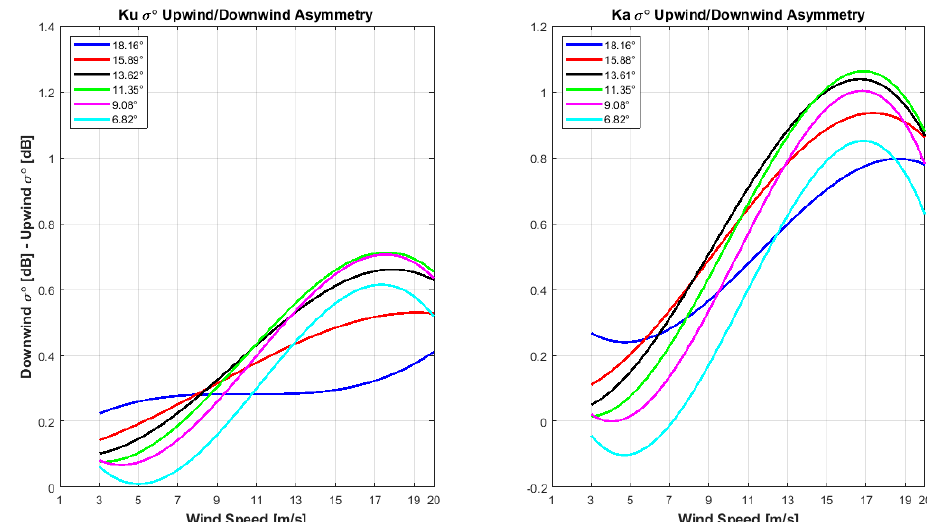
Figure 17. Peak-to-peak KuPR ( left ) and KaPR ( right ) σ 0 downwind/upwind asymmetry (in dB) as a function of WS at different EIAs.